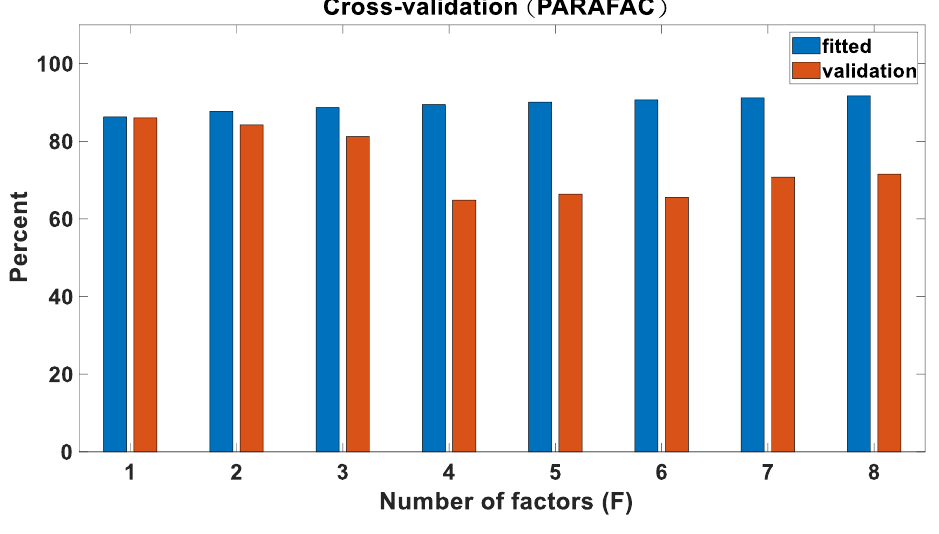
Figure 8. Cross-validation for simulated signal.